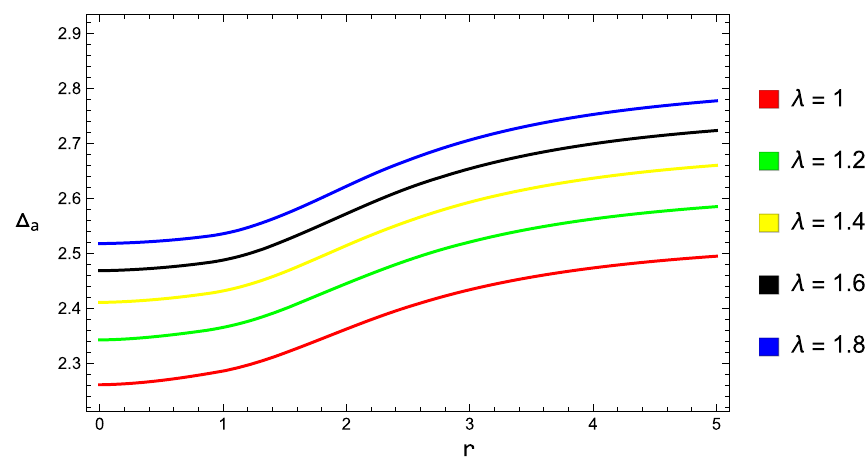
Fig. 8 The variation of (cid:6) a with respect to r for the various values of λ and h 2 ( t ) =